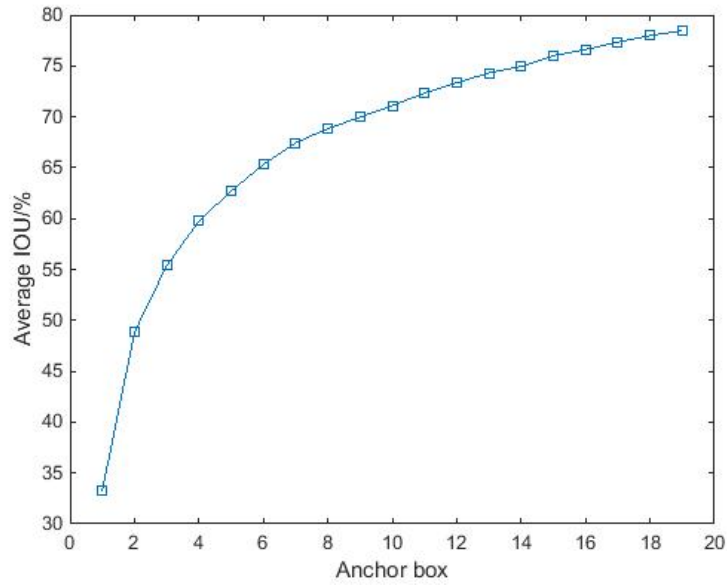
Figure 7. The relationship between average IOU and the number of anchor